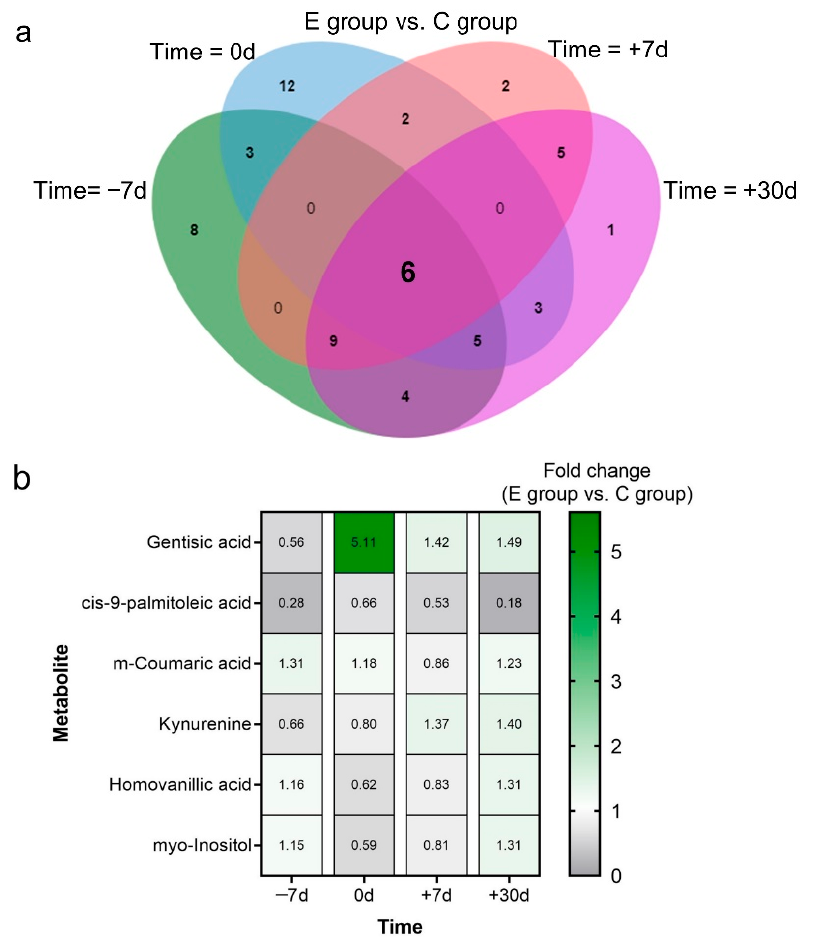
Figure 5. Characterization of key metabolites. ( a ) Venn diagram showing the differential metabolites between the exercise and control groups at − 7 d, 0 d, +7 d, and +30 d relative to calving, respectively. ( b ) Fold change in the levels of six shared metabolites between the exercise and control groups at − 7 d, 0 d, +7 d, and +30 d relative to calving. A fold change greater than one indicates a relatively higher concentration in the exercise group, whereas a fold change of less than one indicates a lower concentration in the exercise group than in the control group.